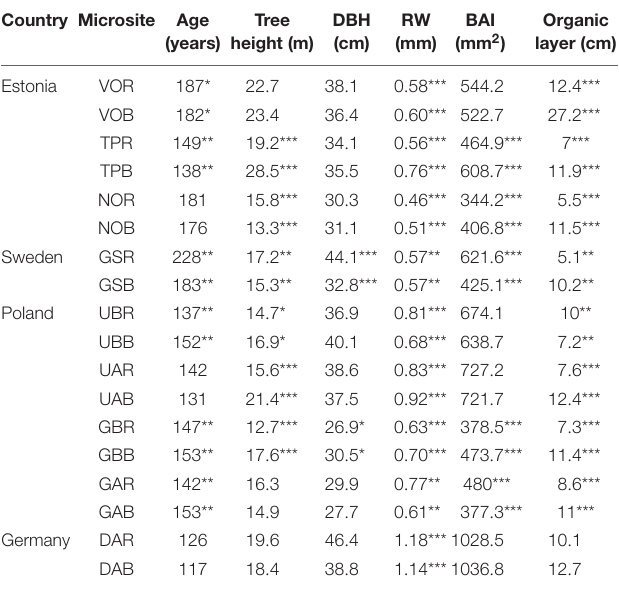
TABLE 2 | The tree metadata (average: age, tree height, diameter at the breast height - DBH, ring-width - RW, basal area increment – BAI, and organic layer) per microsite. Country Microsite Age